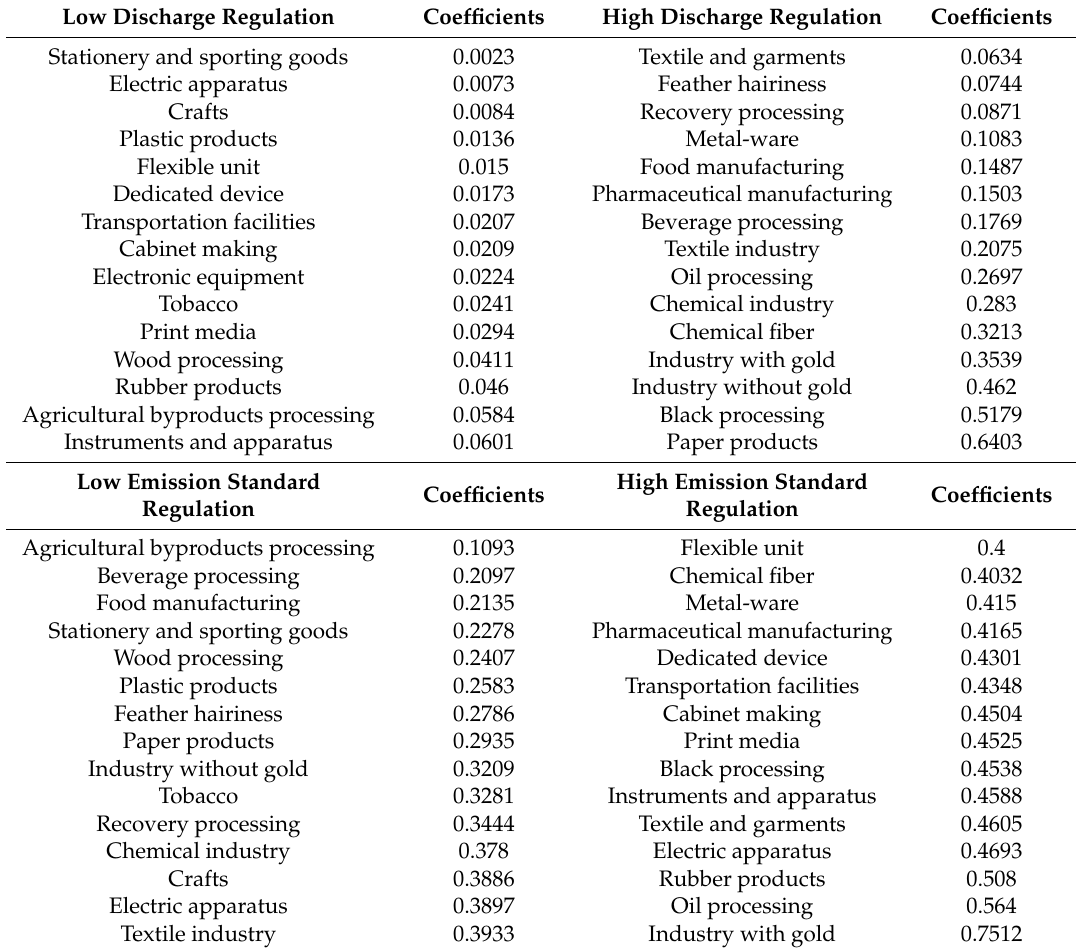
Table 1. Classification According to the Discharge